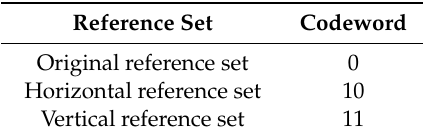
Table 3. Codeword for the multiple reference sets.